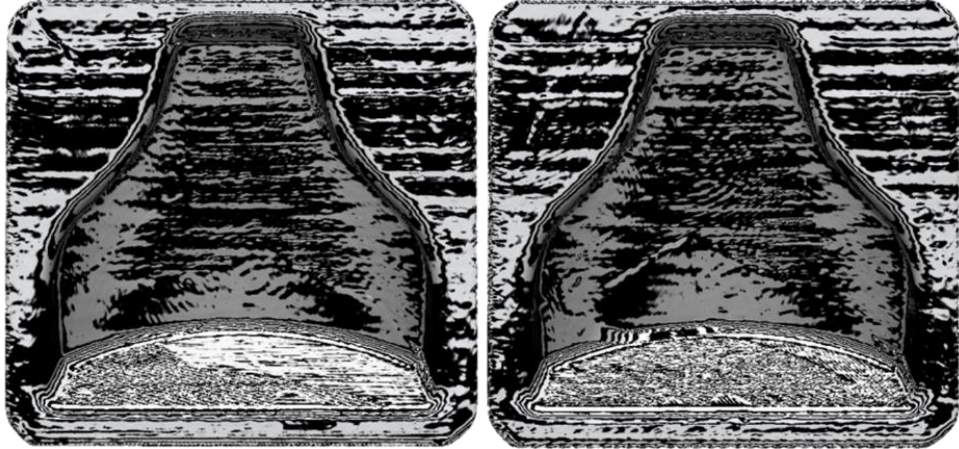
Figure 9. Zebra stripes effect on the two molds after printing, ( left ) mold 1 and ( right ) mold 2.